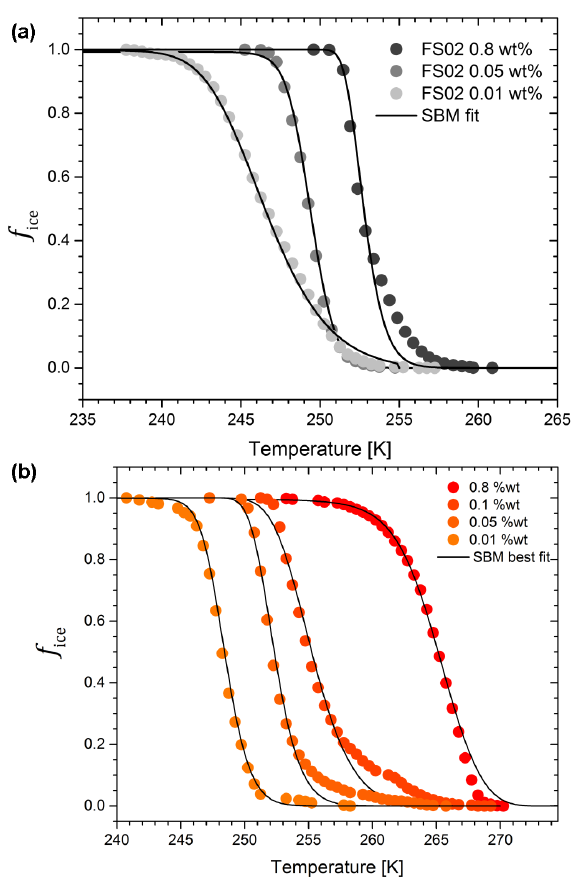
Figure 6. Freezing curves of FS02 (a) and FS04 (b) binned into 0.5K temperature intervals (filled symbols) and SBM best fit (solid curves). Fit parameters are given in Table